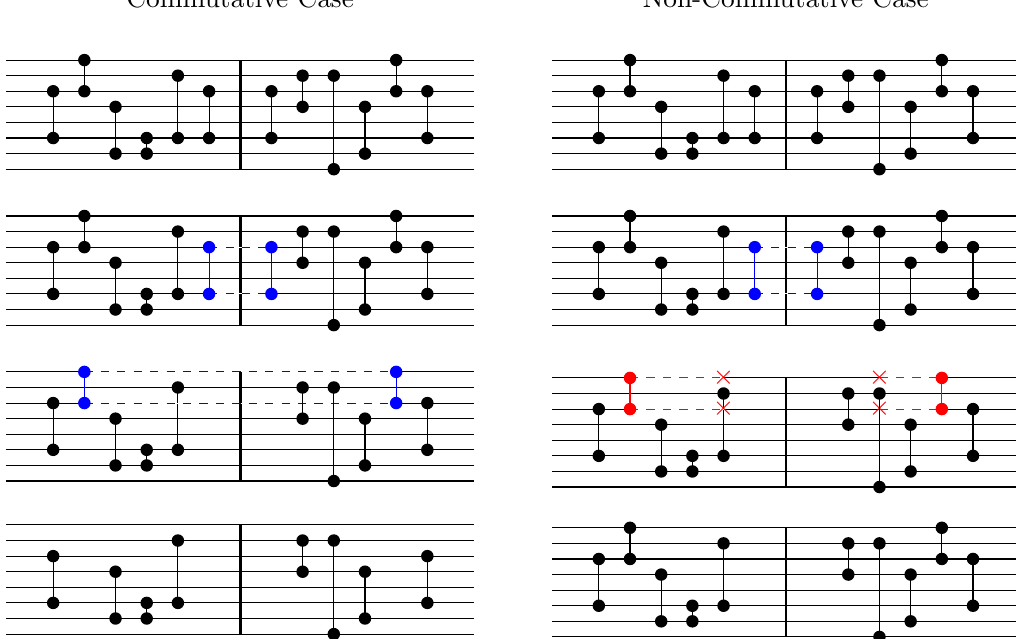
Figure 3 . This circuit represents the end of one copy of a circuit Q U implementing a hypothetical unitary U and the beginning of a second copy of Q U . In this plot horizontal lines are qubits, and the dots connected by vertical lines are gates acting on the pair of qubits they connect.